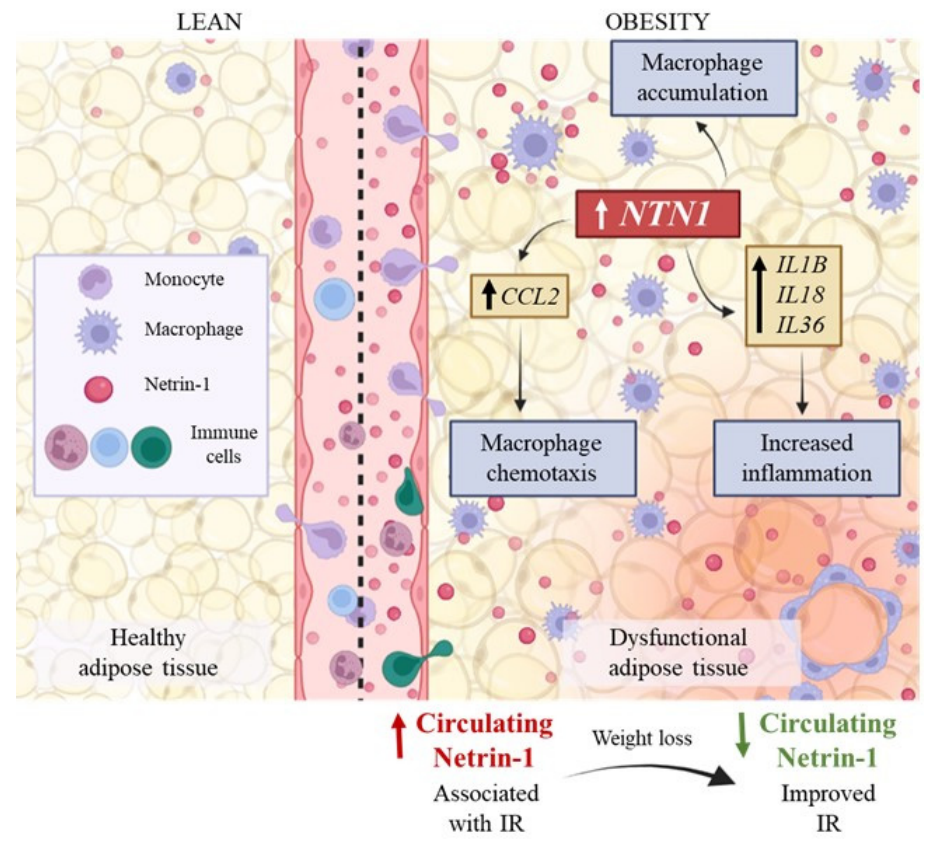
Figure 6. Dysfunctional AT in obesity is characterized by impaired angiogenesis, local hypoxia, and fibrosis, as well as chronic and unresolved inflammation with a special upregulation in the expression of pro-inflammatory adipokines. These metabolic alterations and the limitation in adipose tissue expandability are strongly associated to the onset of obesity-related comorbidities. In this context, the increased expression levels of NTN1 in visceral AT, mainly due to the SVFC, may be favoring inflammation promoting macrophage chemotaxis by the upregulation of CCL2, as well as by the induction of IL1B , IL18, and IL36 . Moreover, the increased circulating levels of NTN-1 in obesity were associated with IR, and the decrease of NTN-1 after caloric restriction were positively correlated with differences in glucose and insulin levels, suggesting the role of NTN-1 in the development of IR. AT, adipose tissue; CCL2 , C-C motif chemokine ligand 2; IL , interleukin; IR, insulin resistance; NTN1 , netrin-1; SVFC, stromovascular fraction